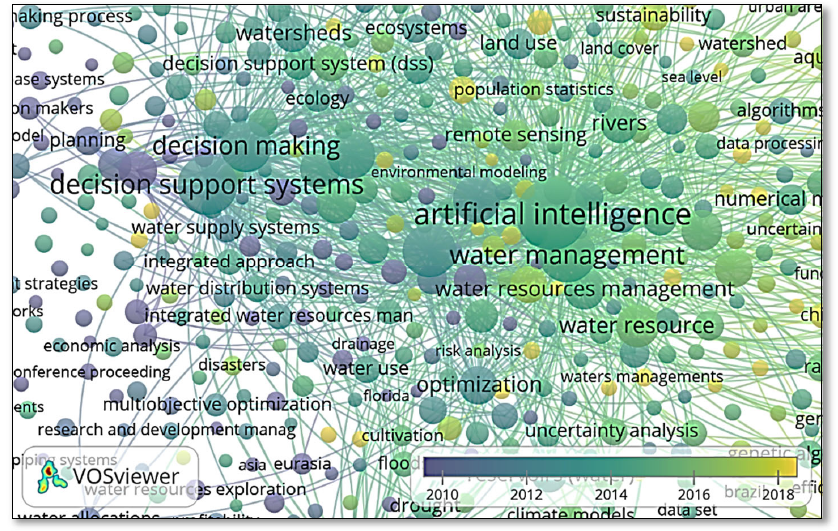
Fig. 4. Bibliometric map of the analysis of the words “intelligence”, “artificial”, for “management”, “resource” and “Water” with the greatest interaction Source: Obtained from the VOSviewer